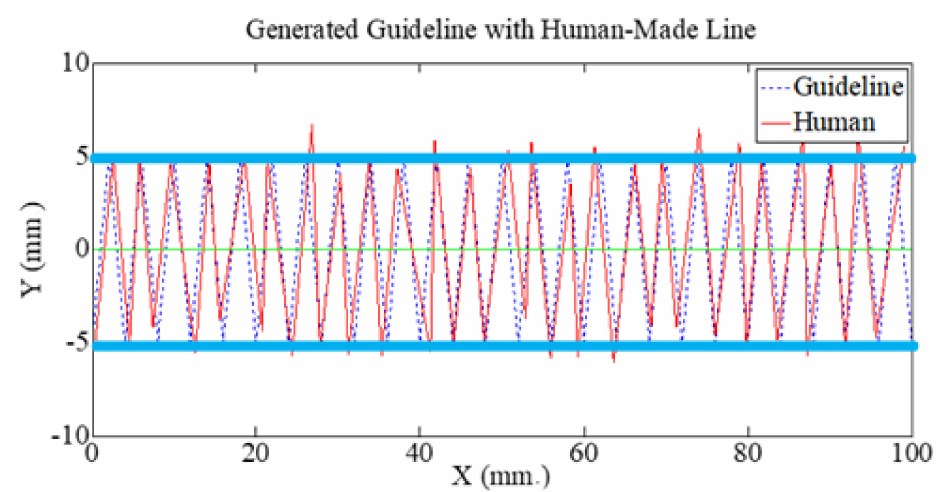
Figure 4. An example of a guideline (dash) with a human-made line